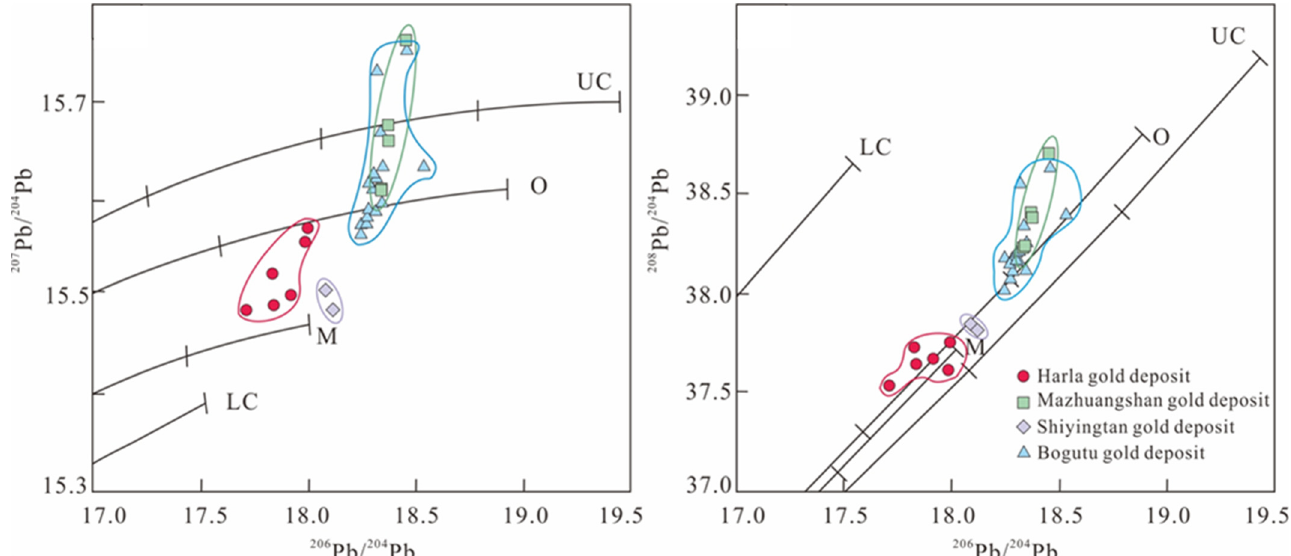
Figure 11. Lead isotope composition diagram of the Harla gold deposit compared with other typical gold deposits. Data for other gold deposits are from Sun et al. [29], Wang et al. [32], and Li and Liu [34]. The average growth curve is from Zartman and Doe [36]. Abbreviations: UC—upper crust; LC—lower crust; O—orogenic; M—mantle.